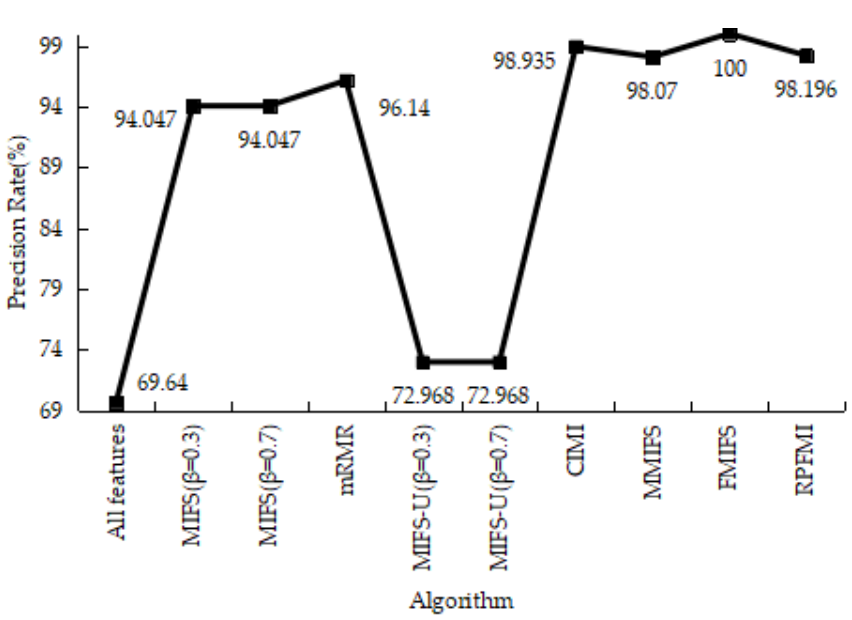
Figure 16. Precision Rate on the Kyoto 2006+ test data.